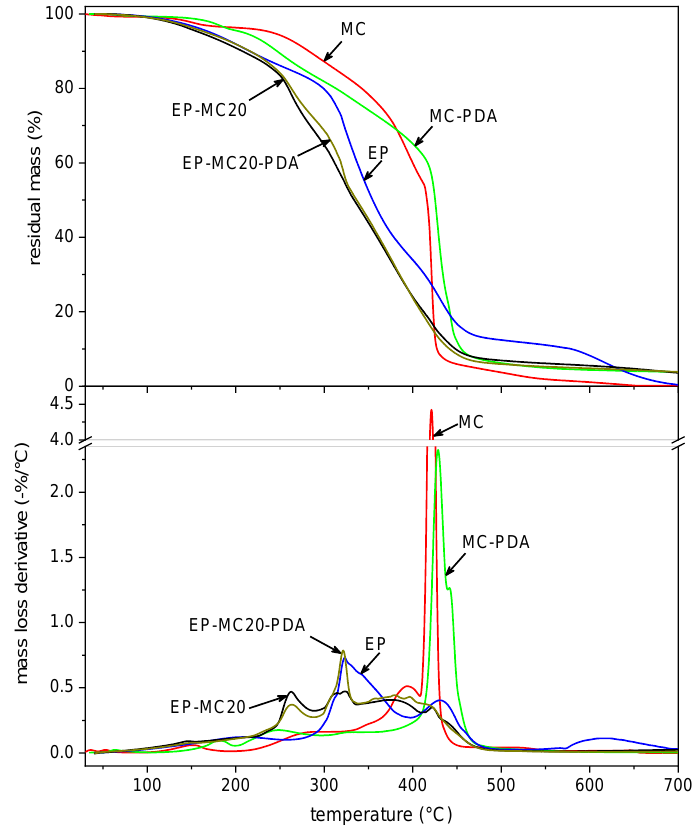
Figure 5. Results of thermogravimetric analysis (TGA) tests on the neat and PDA-coated microcapsules and the prepared composites. Residual mass and mass loss derivative as a function of temperature.